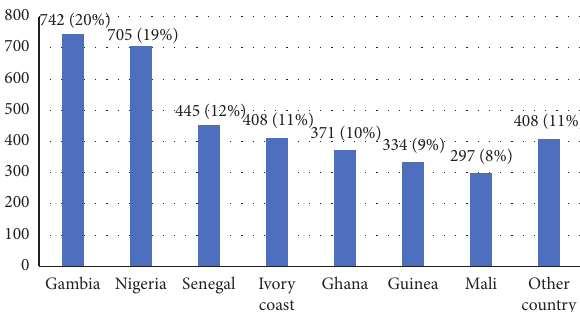
Figure 2: Migrants’ country of origin (total number: